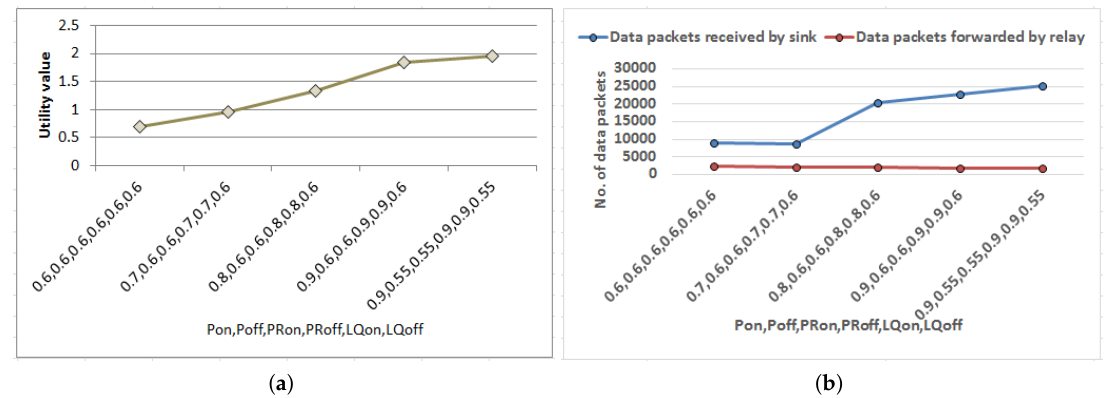
Figure 8. Mapping of MDP formulation into routing strategy. ( a ) Variation of utility values with varying p on , p of f , pr on , pr of f , lq on , lq of f . ( b ) Variation of data packets received by sink with varying p on , p of f , pr on , pr of f , lq on , lq of f